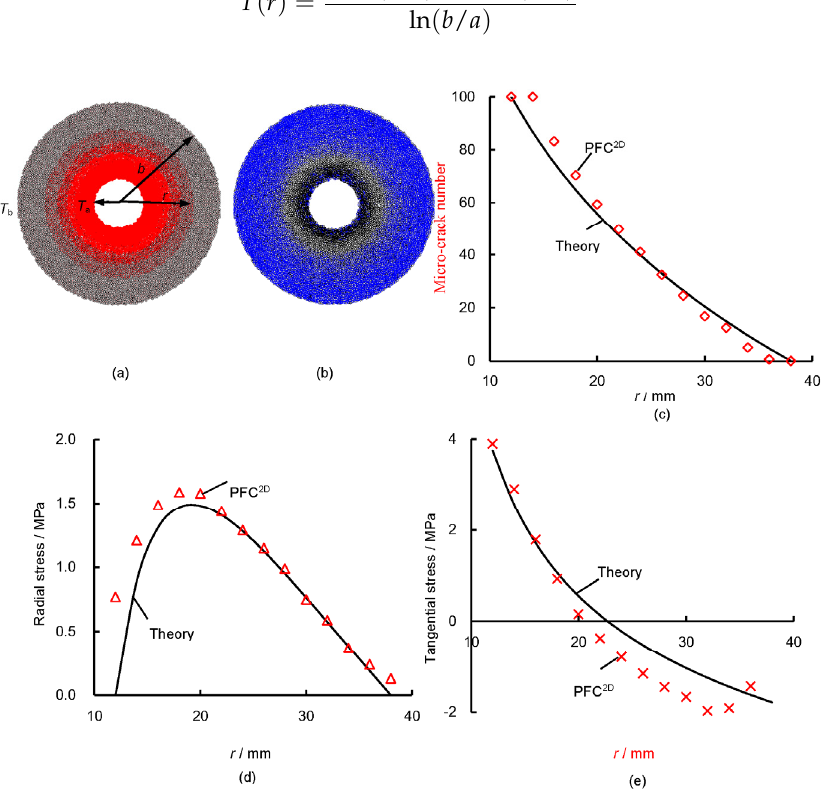
Figure 1. Comparison of numerical results and theoretical results for the annular sample: ( a ) temperature field in the specimen; ( b ) parallel bond forces field in the specimen; ( c ) temperature distributed along the radius; ( d ) radial stress; and ( e ) tangential stress.